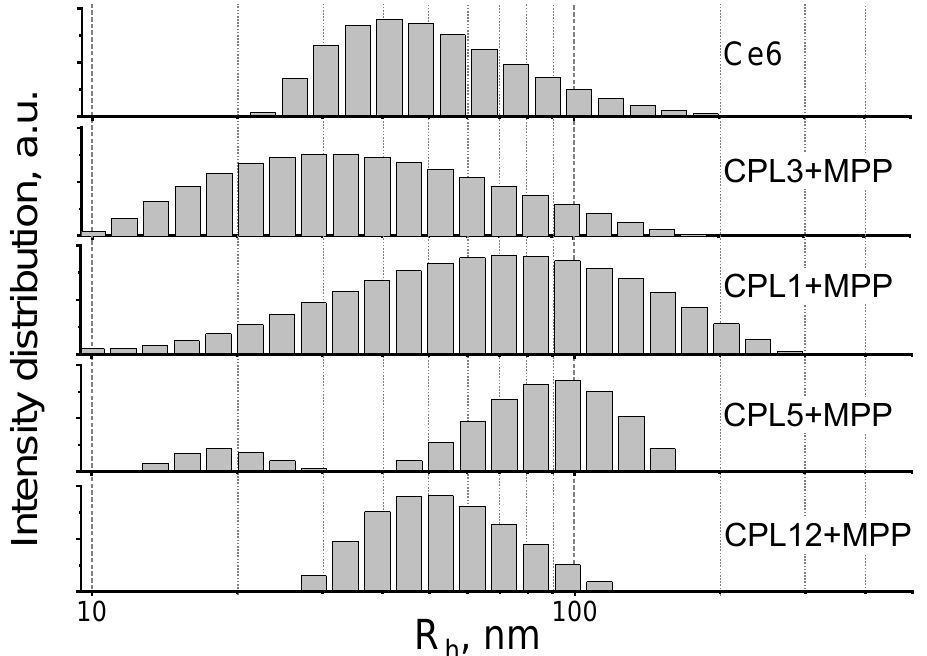
Figure 2. DLS profiles of nanoparticles under study. The PS concentration—10 μM, PBS solution, 20 °C.